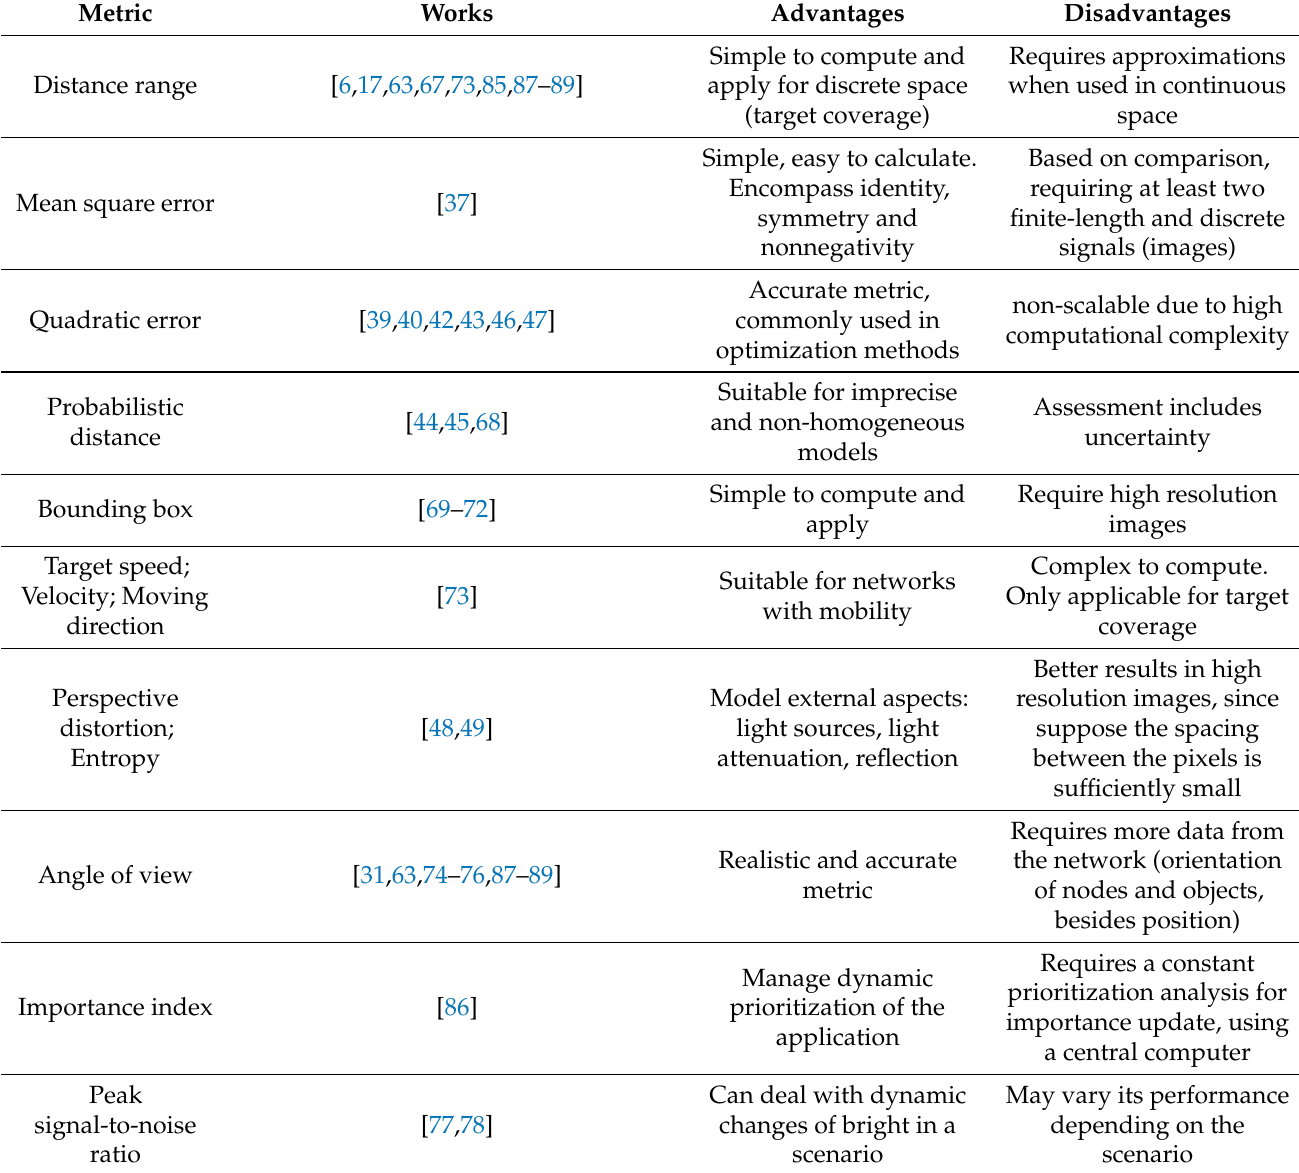
Table 5. Comparative analysis of content quality